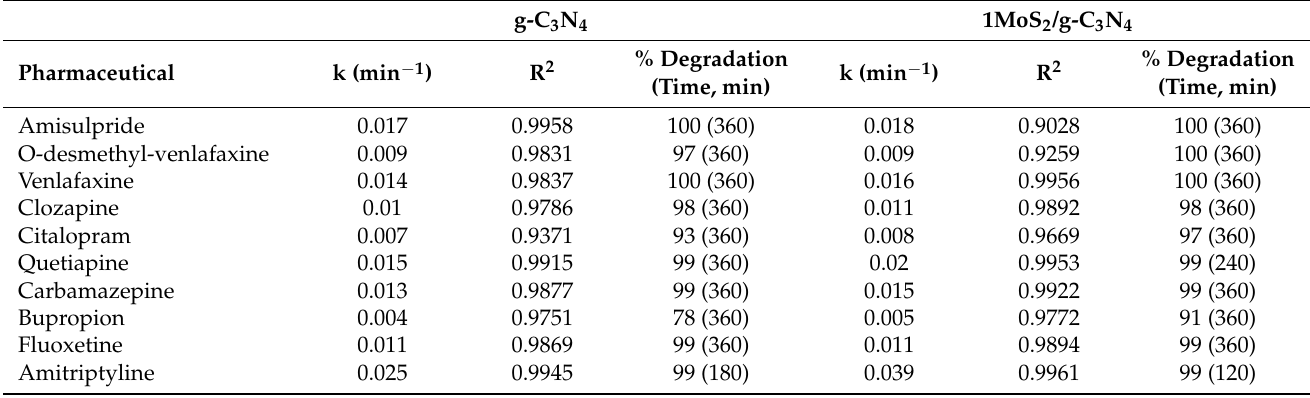
Table 2. Kinetic parameters (rate constants (k, min − 1 ), correlation coefficients (R 2 ), and % degradation of pharmaceuticals) after photocatalytic treatment at laboratory pilot